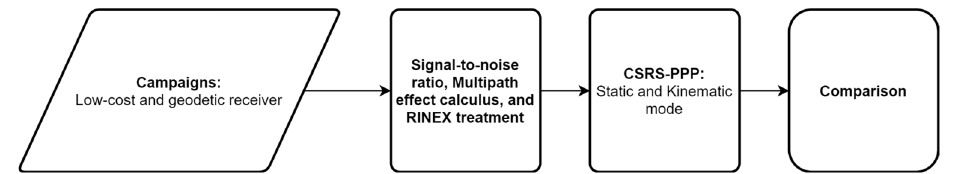
Figure 1. Flowchart for the methodology implemented for the present research.